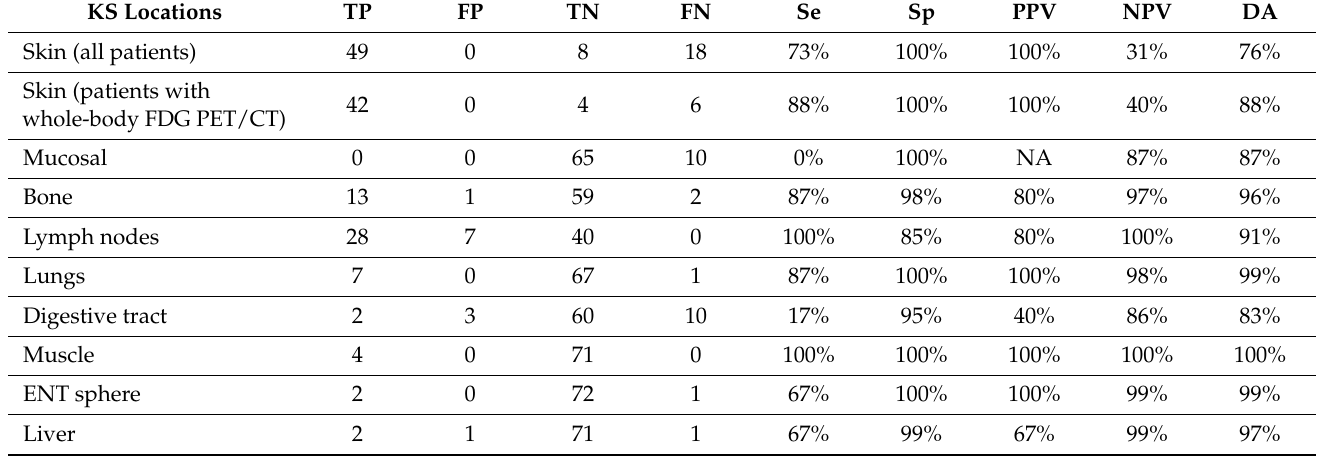
Table 5. Per-site analysis of diagnostic accuracy for FDG